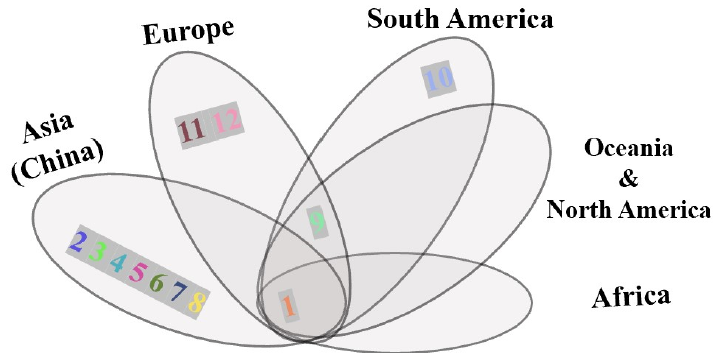
Figure 3. Venn diagram of S. noctilio haplotypes by continent. Numbers and colors correspond to the haplotype network shown in Figure 2.